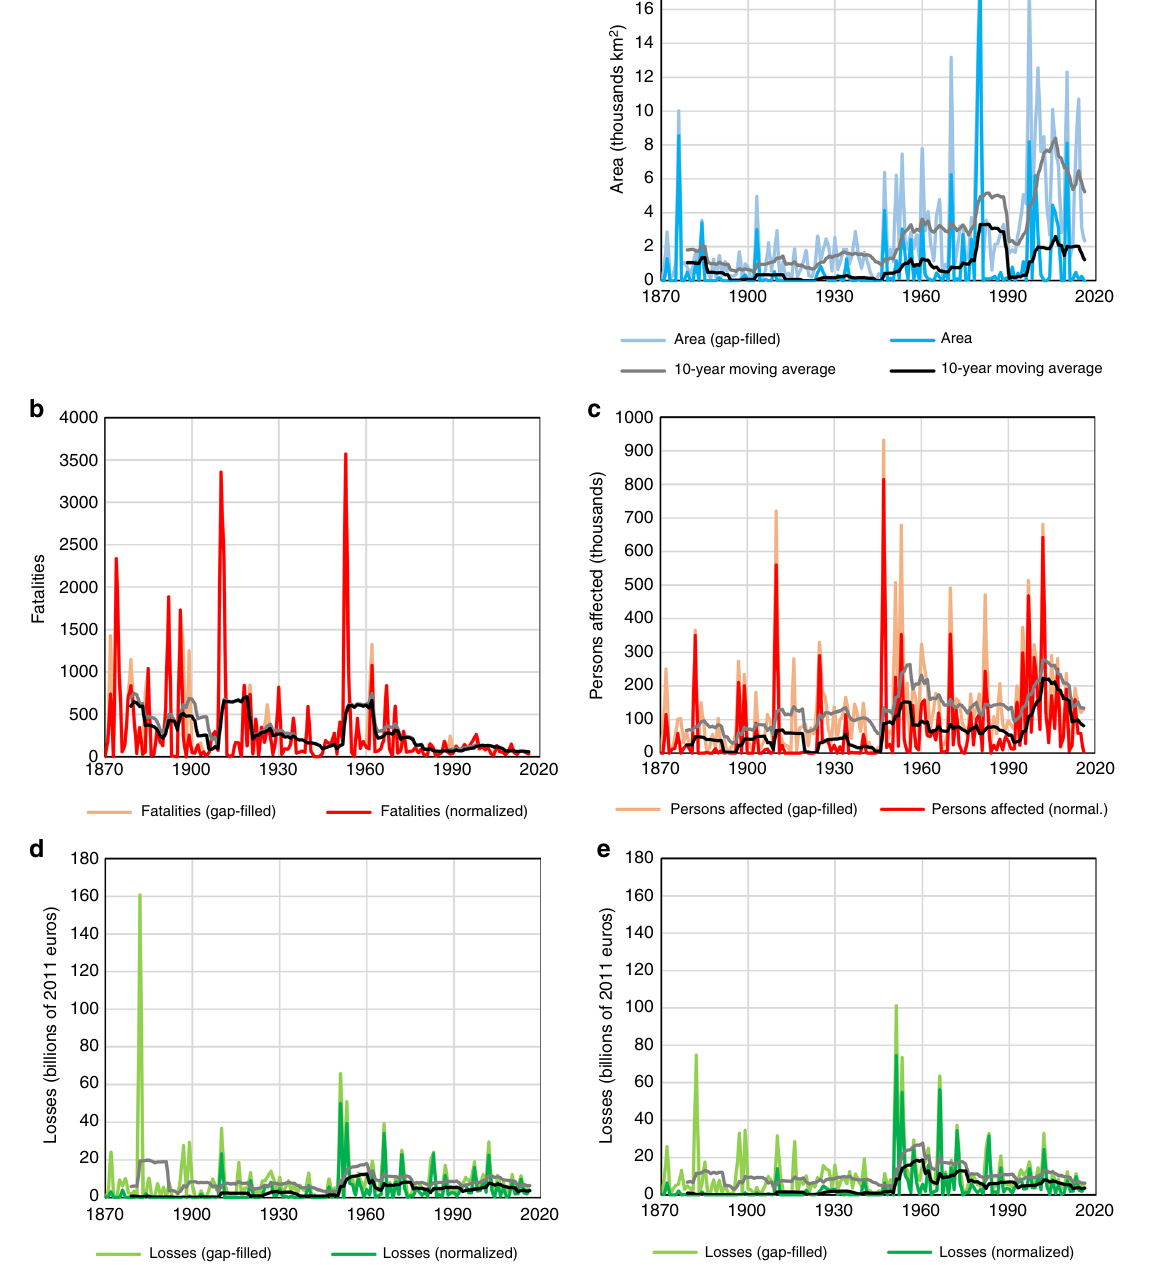
Fig. 4 Trends in normalized fl ood losses per year. Comparison of losses with (lighter colors) and without gap- fi lling (dark colors) for a area inundated; b fatalities; c persons affected; d fi nancial value of losses with normalization by GDP; and e fi nancial value of losses with normalization by